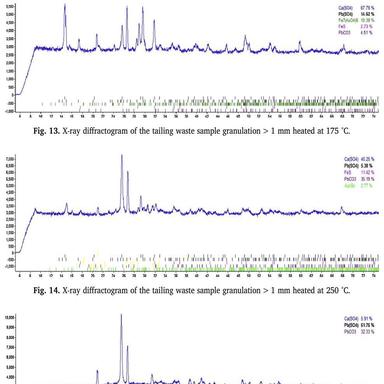
X-ray diffractogram of the tailing waste sample granulation > 1 mm heated at 350 °C.